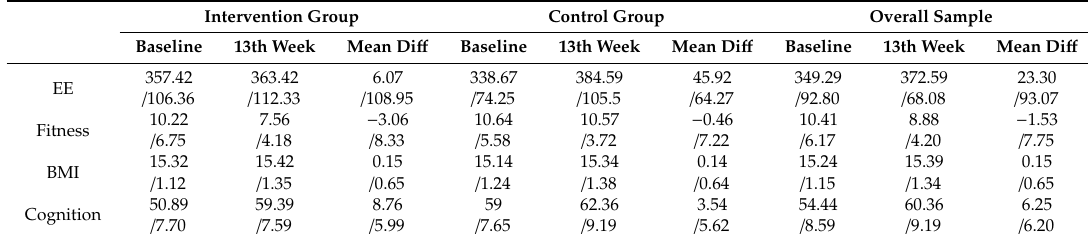
Table 2. Preschool children’s energy expenditure, cardiovascular fitness, BMI, and cognition across